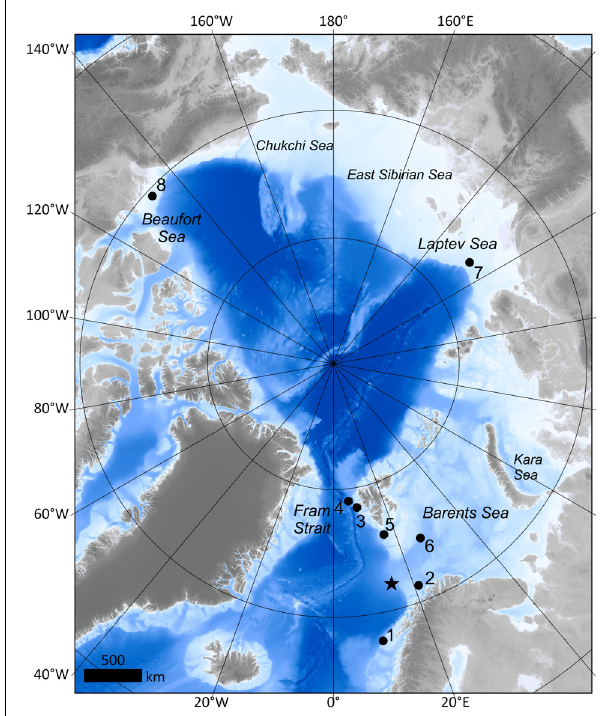
FIGURE 1 | The Arctic and major seas. Seep sites discussed in this review are marked with black circles. Water depths of seep locations are presented in parentheses after the site name. The star marks the location of the Håkon Mosby mud volcano (HMMV) (1,250 m). 1: Lofoten canyons (750–800 m), 2: Svanfjell seep (380 m), 3: Prins Karls Forland (80–350 m), 4: Vestnesa Ridge (1,200 m), 5: Storfjordrenna seep and gas hydrate mounds/pingos (350–390 m), 6: Bjørnøyrenna seep and craters (330–360 m), 7: Laptev Sea (70 m), 8: Beaufort Sea mud volcanoes (280–740 m). Bathymetry for this map was obtained from IBCAO (Jakobsson et al.,